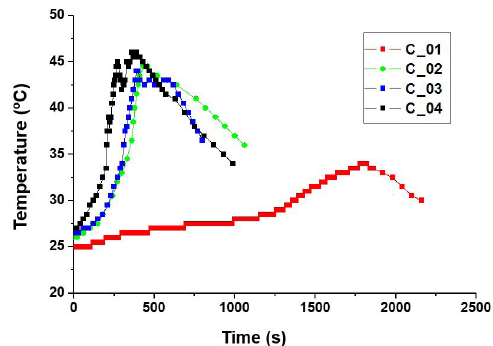
Figure 13. Temperature measured by pyrometry as a function of the time after mixing, of the magnesium phosphate cements prepared from MgO powders calcined at (A) 900 °C / 2 h, with different MgO/ NH H PO ratios and with boric acid/MgO ratio equal to 4 2 4